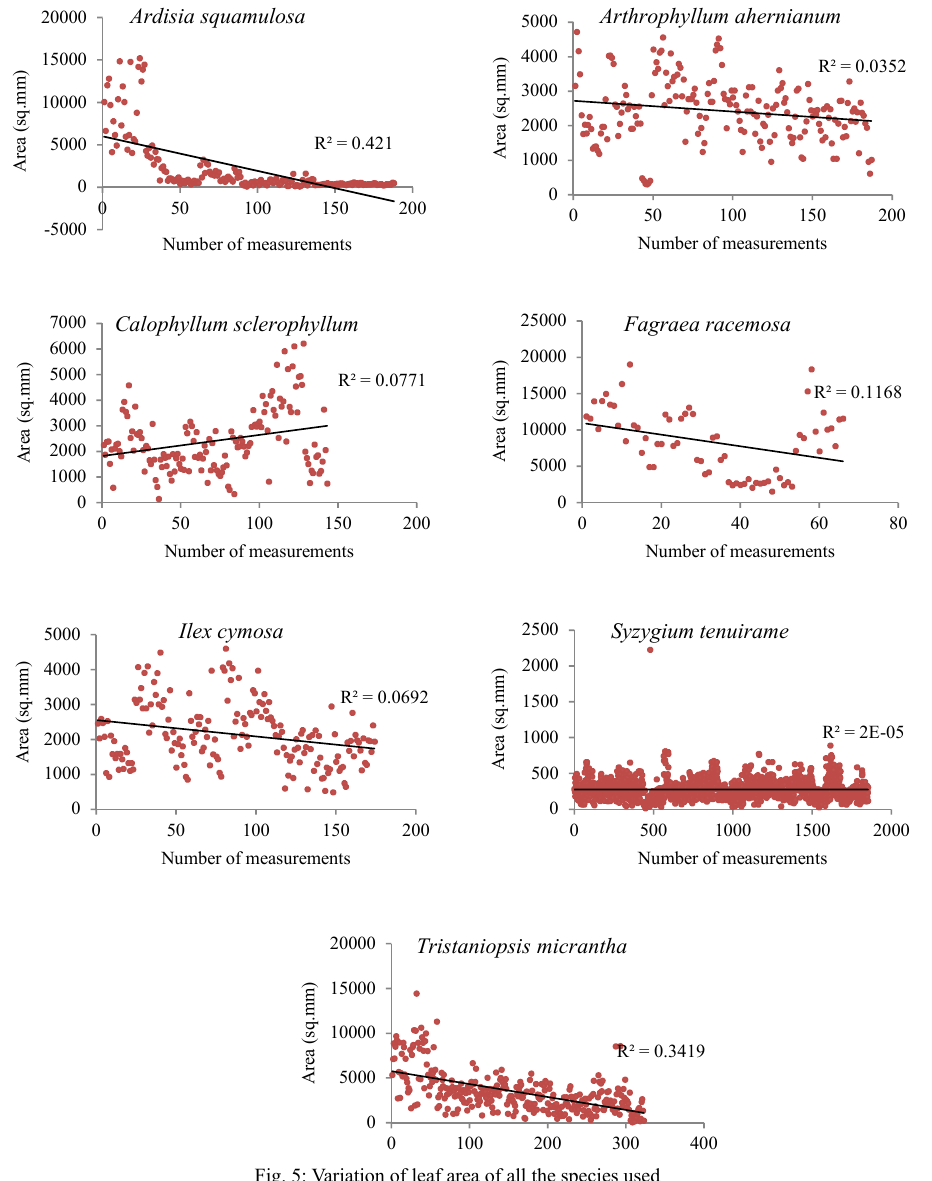
Fig. 5: Variation of leaf area of all the species used